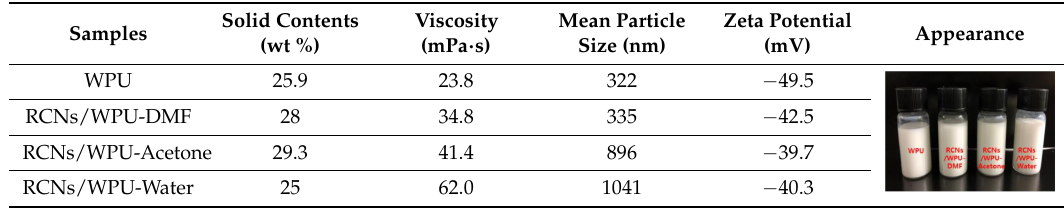
Table 1. Properties of the WPU and RCNs/WPU nanocomposites dispersions obtained with various